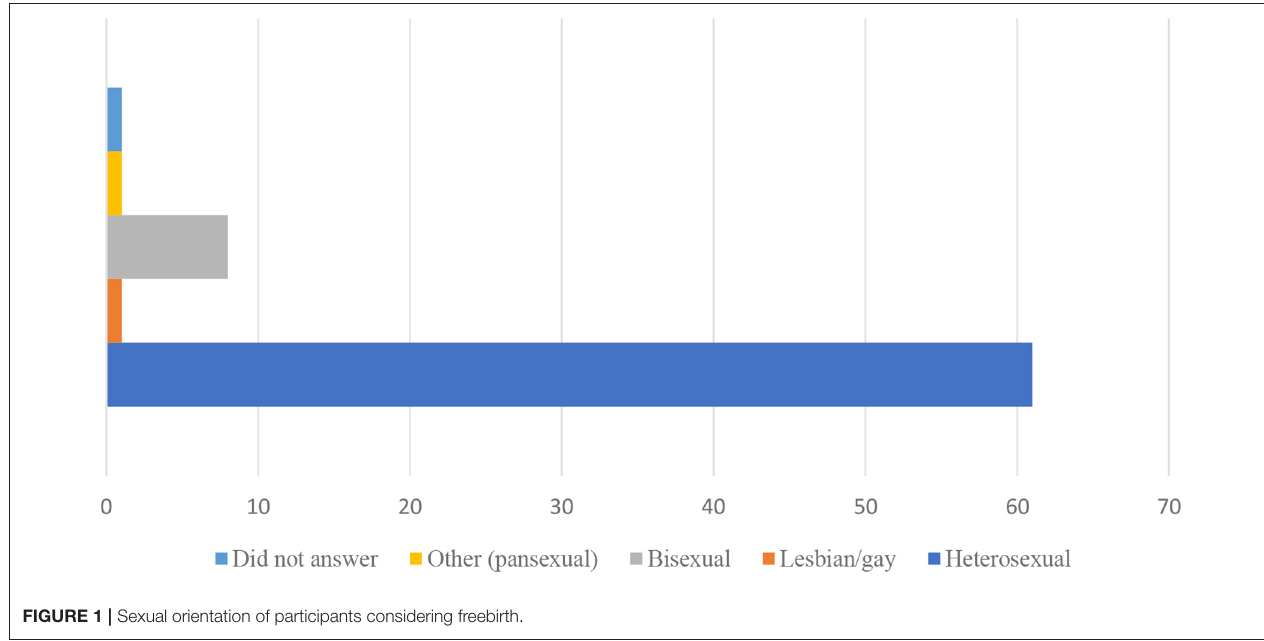
FIGURE 1 | Sexual orientation of participants considering freebirth.